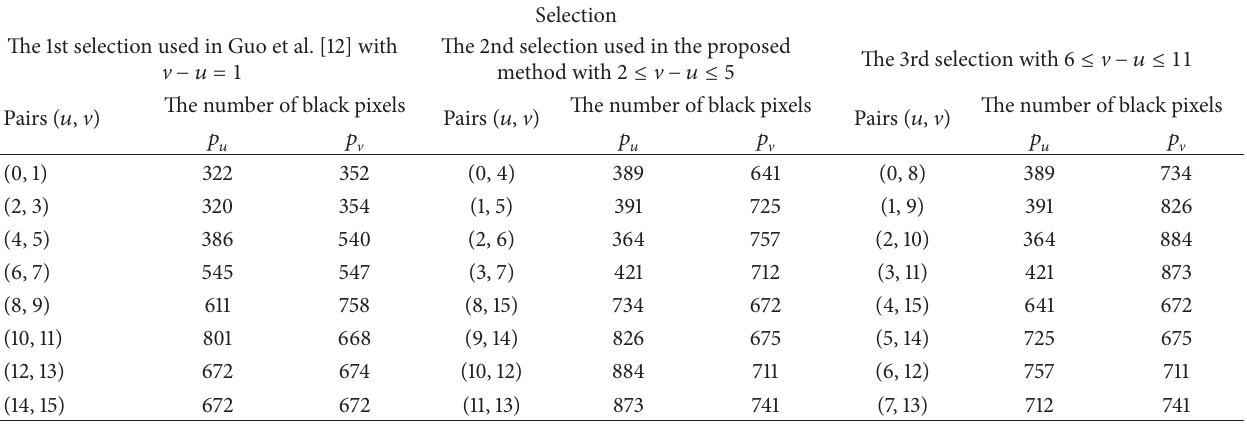
Table 7: The black pixel numbers of the eight pairs in the top-left subimage for different kinds of selections. Selection